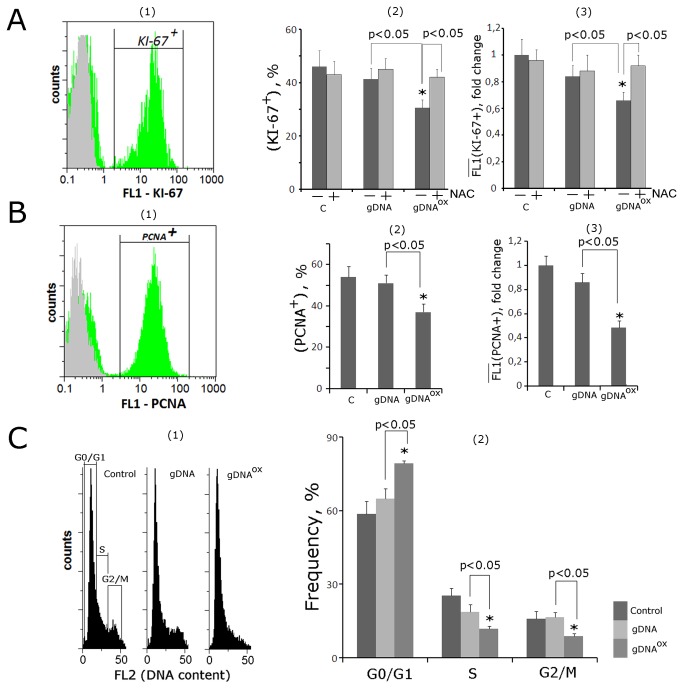
Proliferation and cell cycle of MCF-7 cells exposed to gDNA or gDNAOX at final concentration 50 ng/mL for 48 hours (FACS).A: (1) - fixed cells stained with anti-Ki-67 antibodies (green color). Background fluorescence was quantified using FITC-conjugated secondary antibodies (grey color) [2]. - proportion of Ki-67-positive cells in total cell population [3]. - the average signal intensity of FL1 (Ki-67+). Cells were cultivated either in absence (dark grey columns) or in presence of 0.15 mM NAC (light grey columns). B: (1) - fixed cells stained with anti-PCNA antibodies (green color). Background fluorescence was quantified using FITC-conjugated secondary antibodies (grey color) [2]. - proportion of PCNA-positive cells in total cell population [3]. - the average of the median signal intensities of FL1 (PCNA+).C: (1) - distribution of fluorescence intensities of the cells stained with пропидий йодидом. (2) - содержание в популяции клеток с количеством ДНК, соответствующим G1-, S and G2/M –фазам клеточного цикла.*p < 0.05 against control group of cells, non-parametric U-test.